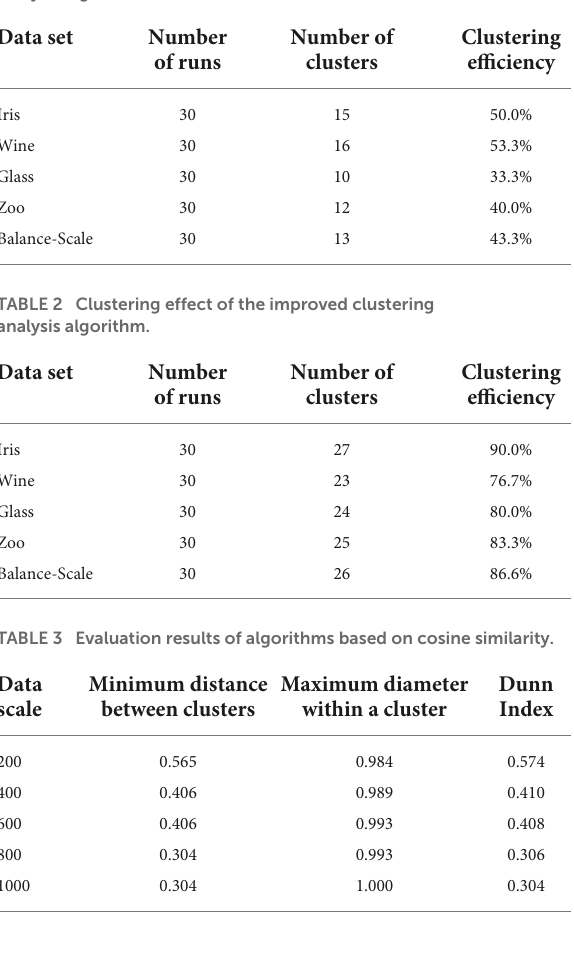
TABLE 1 Clustering effects of traditional clustering analysis algorithms.